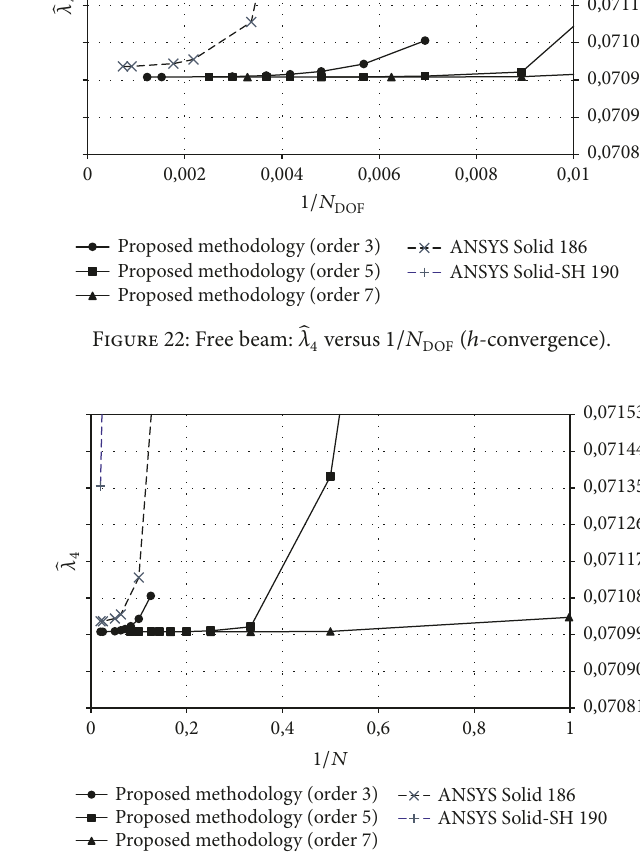
̂𝜆 1/𝑁 ( ℎ 4 versus